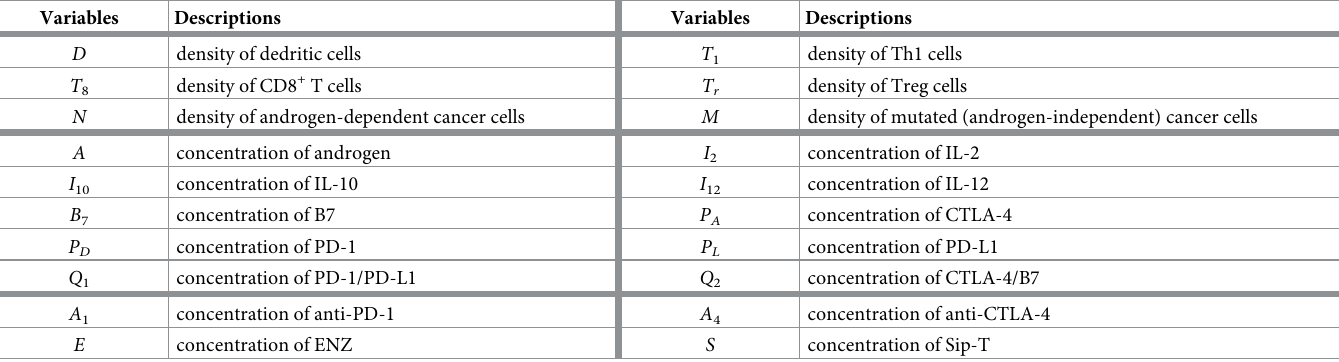
for some constant θ > 0. We assume that the densities of immature dendritic cells and naive CD4 + and CD8 + T cells remain constant throughout the tumor tissue. Under Assumption (1), proliferation of cancer cells and immigration of immune cells into the tumor, give rise to inter- nal pressure which results in cells movement with velocity, u ; u depends on space and time and will be taken in units of cm/day. We assume that cytokines and anti-tumor drugs are dif- fusing within the tumor, and that also cells undergo diffusion (i.e., dispersion). activation of species Y by species X, and by Y of Y by X. If Y is activated by two species, X and X , then we separately add each of the 1 2 Table 1. Variables of the model. All concentrations are in units of g/cm 3